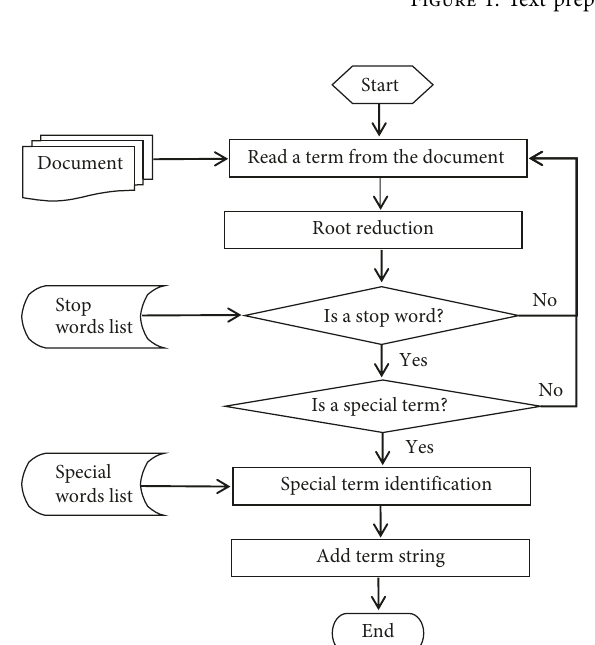
Figure 2: The process of text preprocessing.